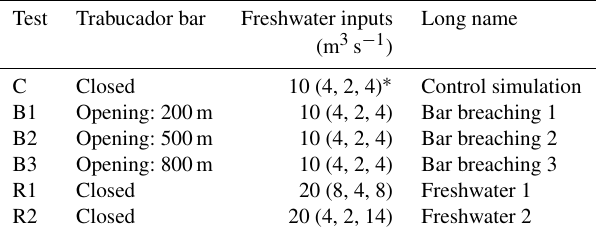
Table 2. Numerical experiments and main